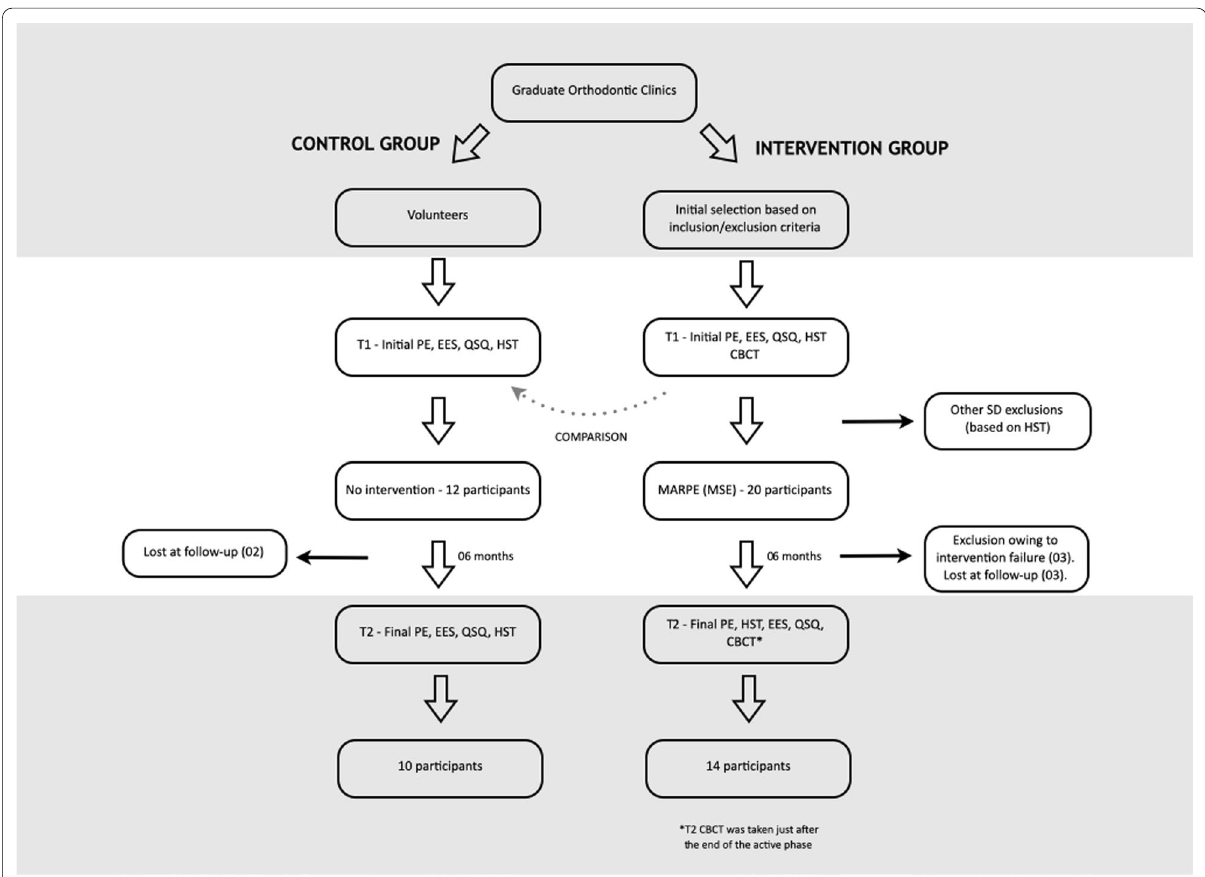
Fig. 1 The study flow diagram. PE, Physical Evaluation; ESS, Epworth Sleepiness Scale; QSQ, Quebec Sleep Questionnaire; HST, Home Sleep Test; CBCT, Cone Beam Computerized Tomography; MSE, Maxillary Skeletal